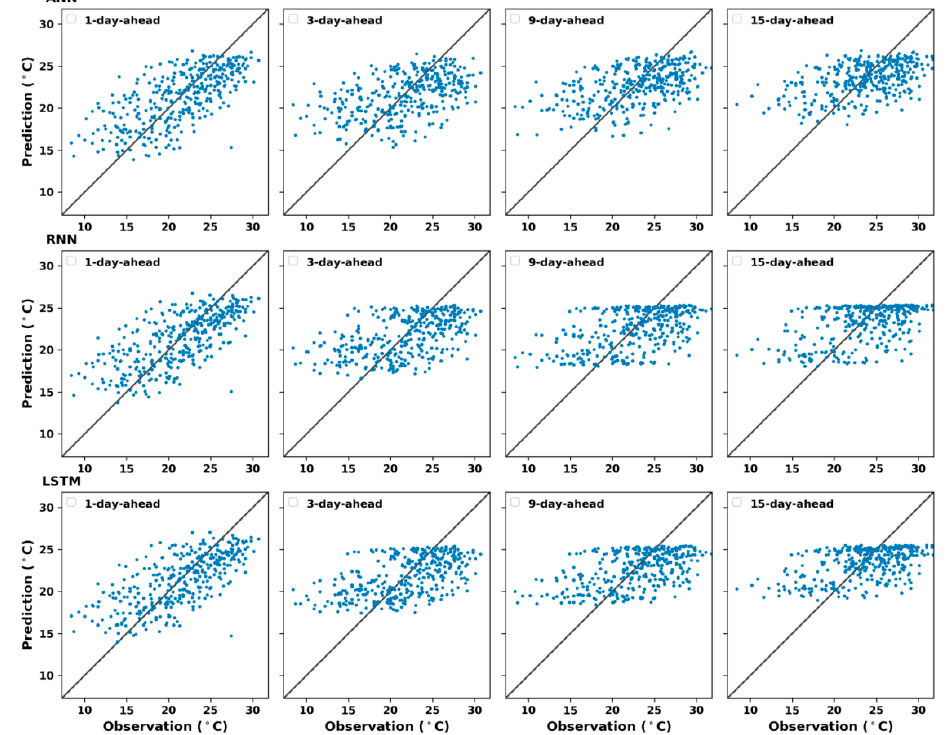
Figure 12. Prediction of k days ahead using ANN ( top ), RNN ( middle ), and LSTM ( bottom ) models for spring, k = 1,3,9,15 .